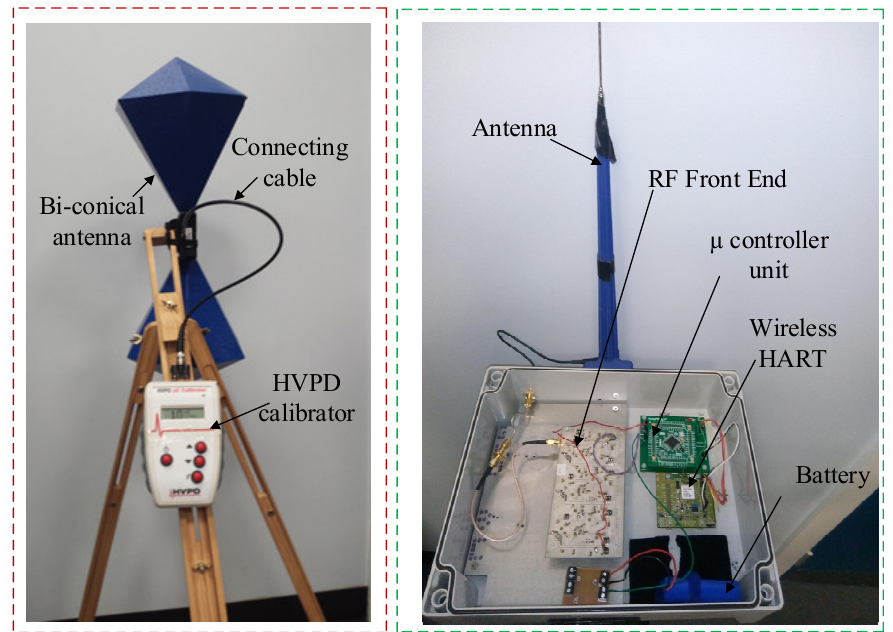
Figure 4. Biconical antenna with PD calibrator and the radiometric sensor used.